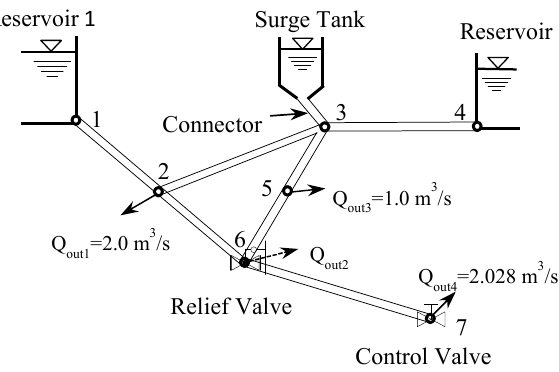
Figure 4. Sketch map of the simple hydraulic network.